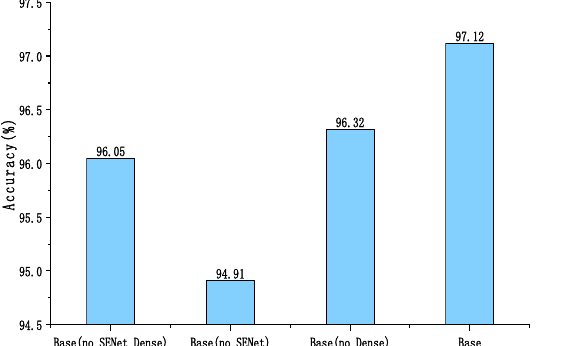
Figure 14. The effect of SENet and dense connection strategy on the accuracy of the convolution